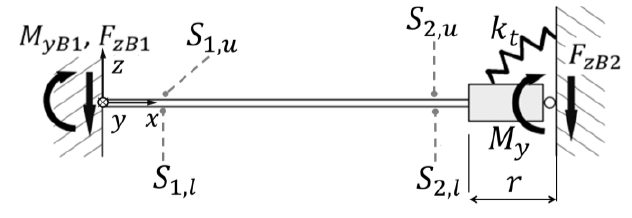
Figure 6. Load Condition B for beam-1 a torque M = F applied at x = l b